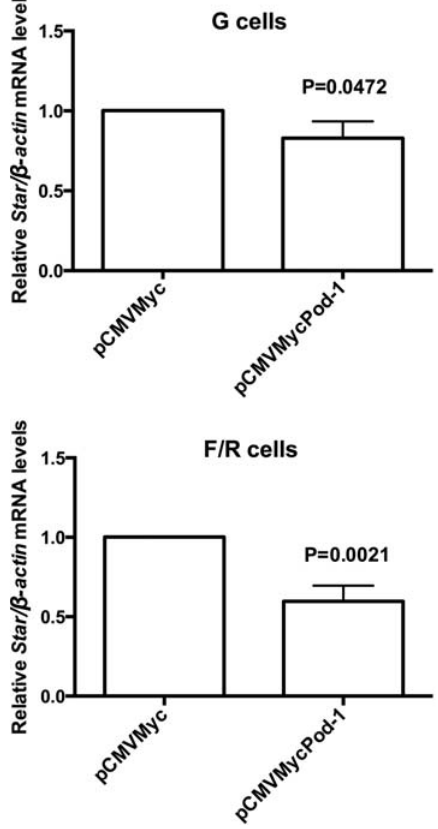
Figure 6. Quantitative reverse transcription PCR (qRT-PCR) analysis of relative Star/ b -actin mRNA levels in primary rat adrenal glomerulosa cells (G cells) and fasciculata/reticularis cells (F/R cells) that had been transiently transfected with the pCMVMyc (empty vector) or pCMVMycPod-1. mRNA samples were prepared 48 h post-transfection. Data are reported as the means ± SD from three experiments. Statistical signi fi cance was assessed by paired t